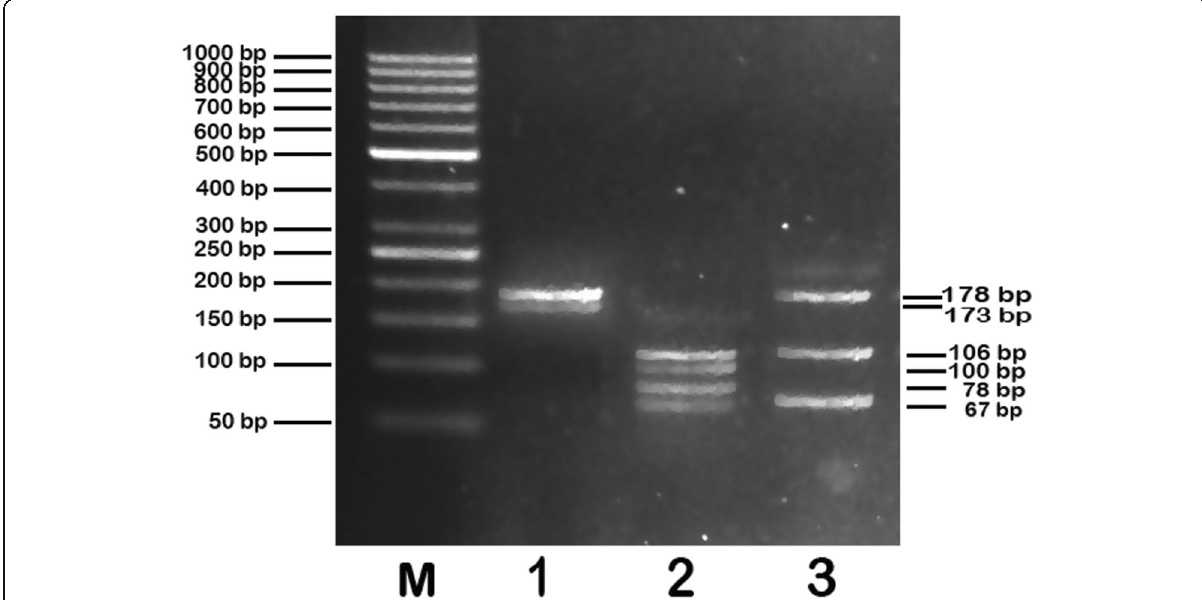
Fig. 2 The electrophoretic pattern after digestion of the goat DGAT1 gene fragment with NlaIII endonuclease. M, 50 bp ladder marker. Lanes 1 and 2, homozygous genotypes (CC and TT, respectively). Lane 3, heterozygous genotype